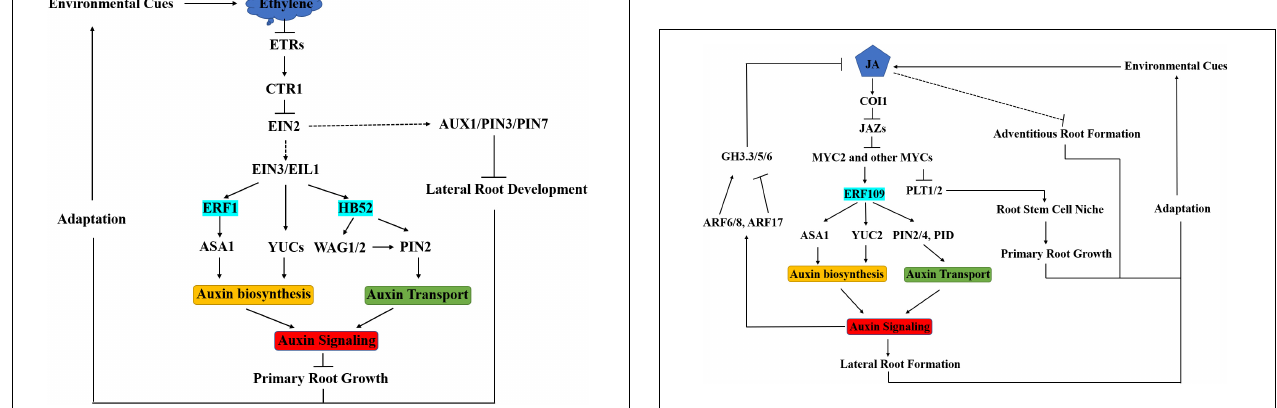
FIGURE 1 | Integration of Ethylene into Auxin Signaling in Arabidopsis Root Development. Environmental cues trigger the biosynthesis of ethylene in Arabidopsis, and then ethylene binds to ETR receptors to inactivate CTR1, which functions to repress EIN2. When EIN2 is released by CTR1, it can be cleaved and then helps to stabilize EIN3/EIL1, leading to the activation of downstream transcriptional cascades. Ethylene inhibits primary root growth by regulating auxin biosynthesis, transport, and signaling. ERF1 and HB52 function as crosstalk nodes between ethylene and auxin in this process. An increase in endogenous ethylene enhances auxin transport and reduces lateral root formation depending on AUX1, PIN3, and PIN7. The ERF1 and HB52 regulatory modules are part of the molecular mechanisms in the adaptive response of root growth to environmental cues.